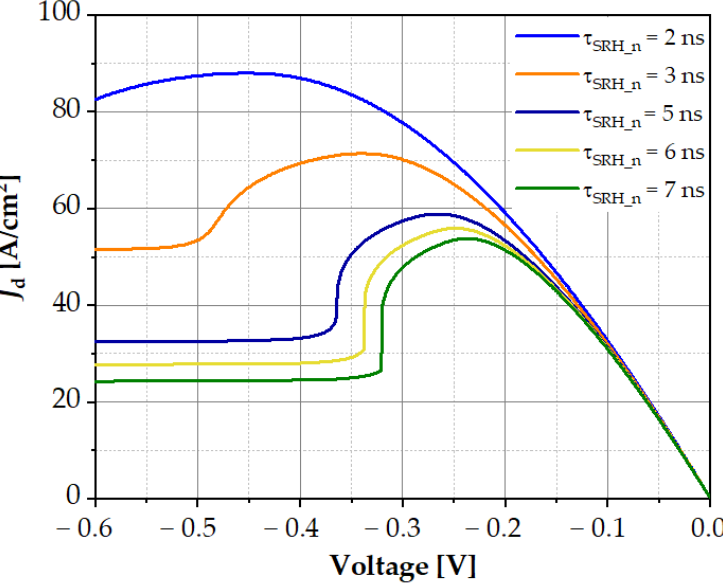
Figure 9. Calculated dark current versus voltage of the LWIR2 structure for different SRH recombination lifetimes at temperature T = 300 K.